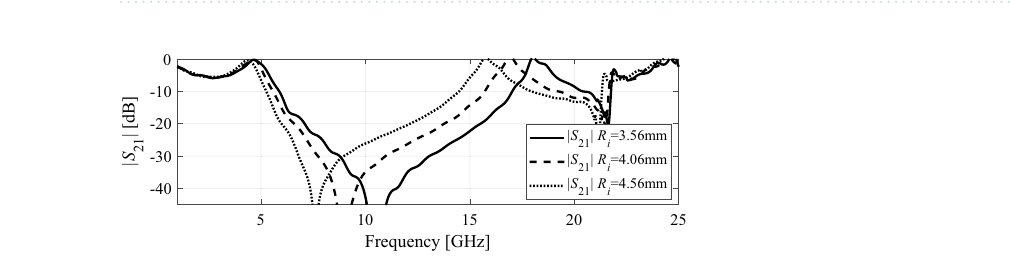
Figure 4. Comparison of transmission coefficients (|S 21 |) of the FSS unit cell for different lengths of the cross- dipoles.